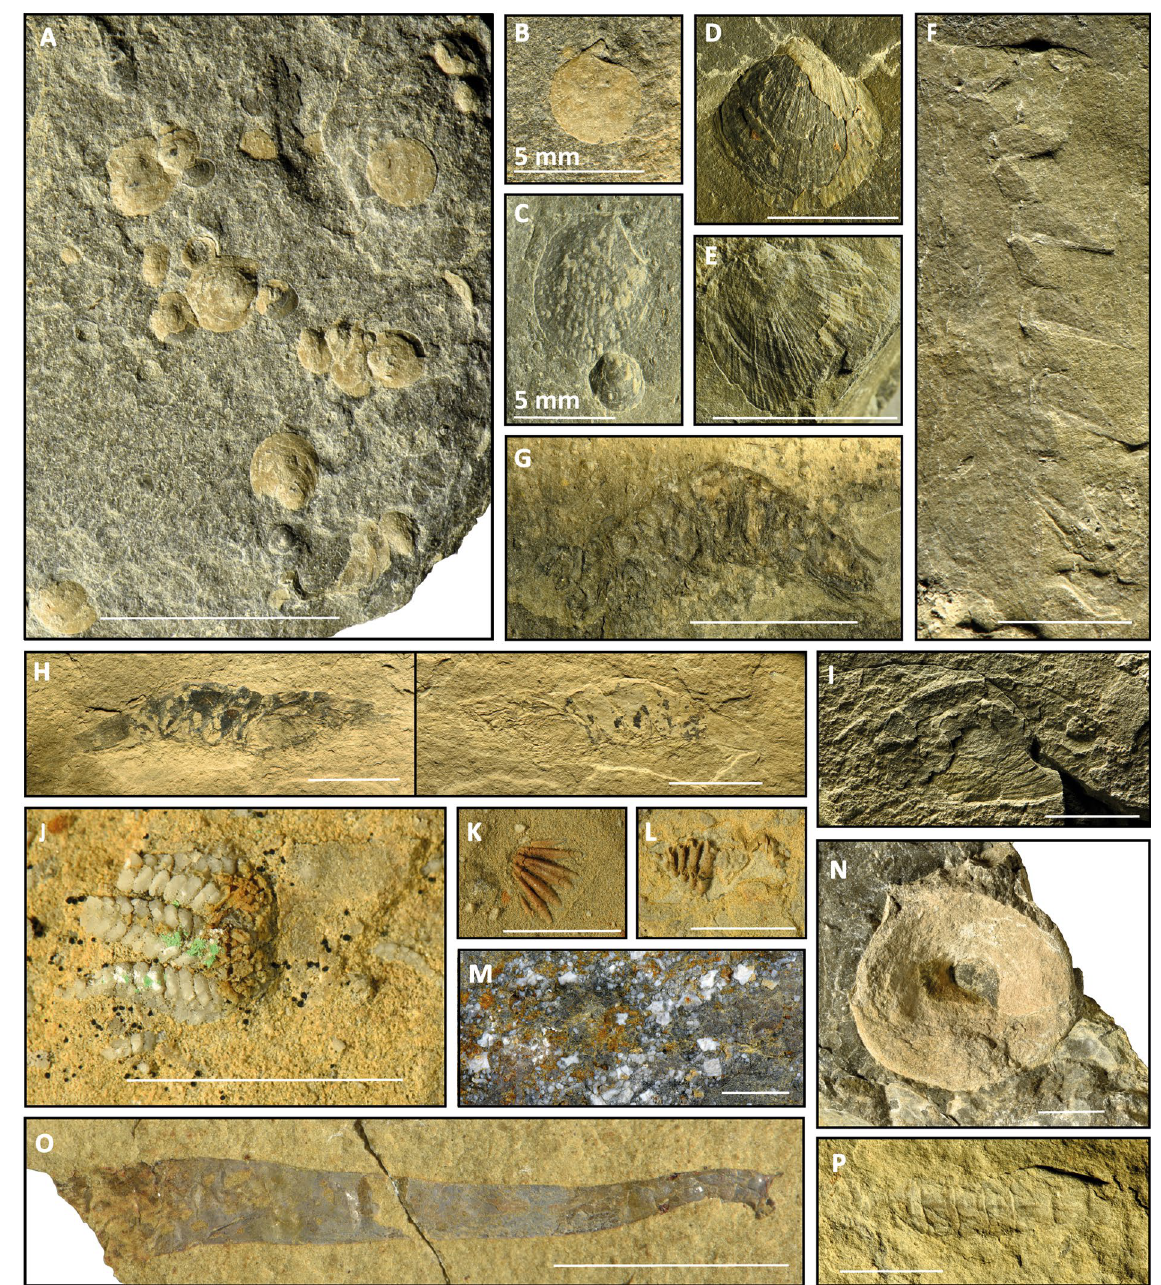
Figure 4. ( A – I ) Components of the NN fossil assemblage. ( J – P ) Components of the IC fossil assemblage. ( A ) Multiple Bivalves Pleuronectites meeki (UBGD33001) . ( B ) Right valve of Pleuronectites meeki (UBGD33001) . ( C ) Right valve of Leptocondria occidanea (UBGD33002a) . ( D ) Bivalve Leptochondria sp. (UBGD33003) . ( E ) Bivalve Leptochondria virgalensis? (UBGD33002b) . ( F ) Horseshoe crab thoracetron imprint (UBGD33004) . ( G ) Possible penaeoid shrimp (UBGD.NMMNH1) . ( H ) Penaeoid shrimp (UBGD33022) . ( I ) Thylacocephala Ligulacaris parisiana (UBGD32324) . ( J ) Ophiuroid (UBGD33016a) . ( K , L ) Rhynchonellata brachiopods (UBGD33018; UBGD33016b) . ( M ) matrix filled with entroques (UBGD33021). ( N ) Ichthyosaur vertebra (UBGD33019) . ( O ) Leptomitid protomonaxonid sponge Pseudoleptomitus advenus (UBGD33020). Scale is 1 cm. ( P ) Pleon of a Glypheoidea lobster (UBGD33017) . Unless specified otherwise scale is 1 cm. Figure created using Adobe Illustrator (v.